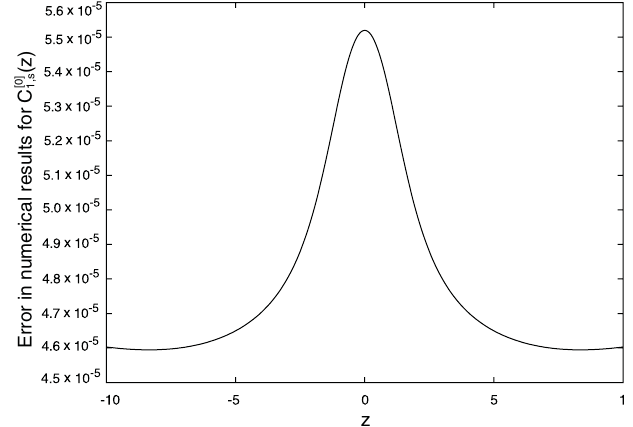
ð z Þ . Exact results ;s